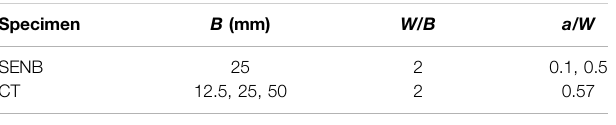
TABLE 1 | Geometry sizes used in FE